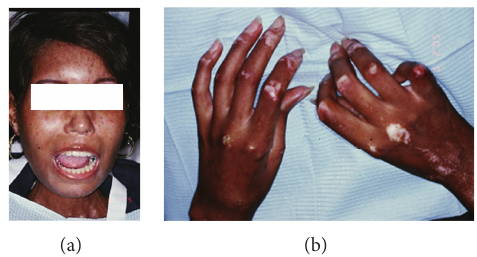
Figure 1: (a) The involvement of the facial skin with abnormal col- lagen deposition produces a mask-like face. Note the hypopigmen- tation, telangiectasias, loss of alae of the nose, and taut skin around the neck. (b) Sclerodactyly with hypopigmentation, telangiectasias, and flexion contractures of the fingers.